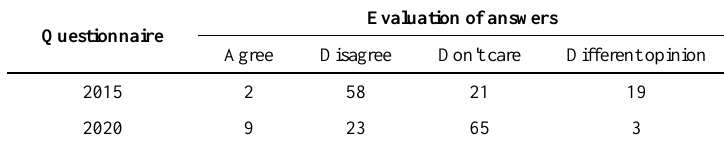
Table 6. Comparison of the opinions of using the ammunition storage site in 2006-2014 (in %)